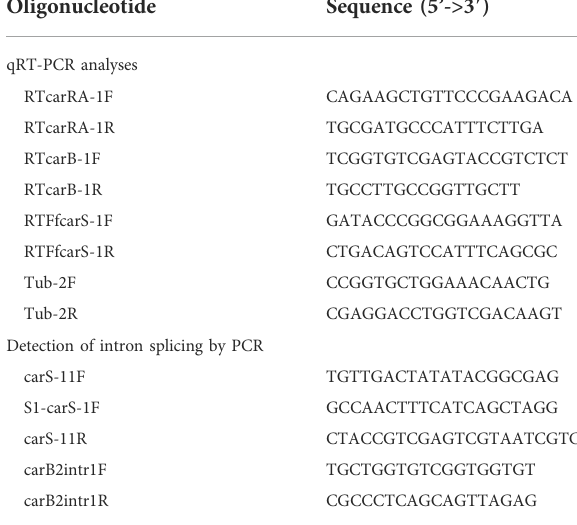
TABLE 1 Oligonucleotides used in this